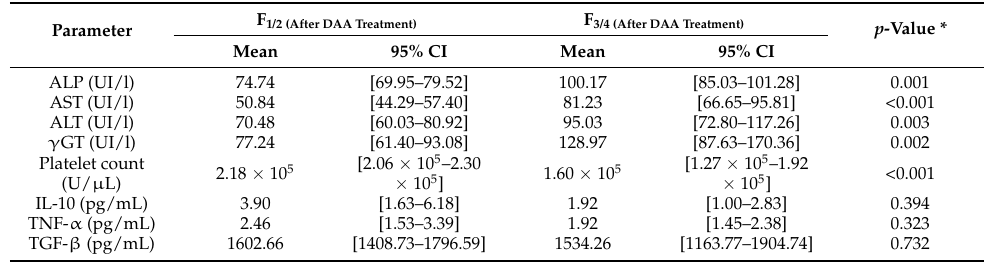
Table 2. Association of baseline biochemical and cellular parameters and cytokines (continuous variables) with fibrosis stage after DAA treatment.